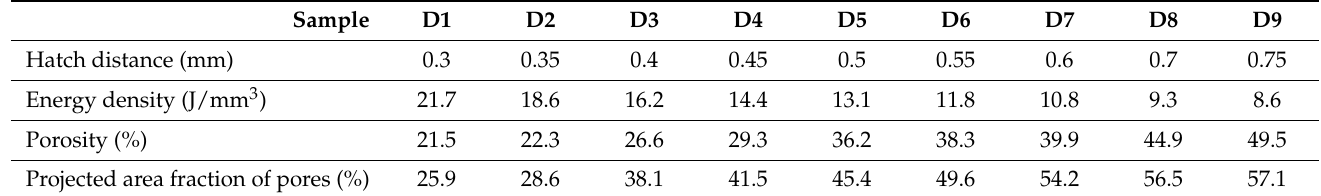
Figure 1. SEM image of printed structures showing average 0.13 mm scan line width and 0.3 mm hatch distance (or D1 specimen in Table 2). Table 2. SLM process parameters and porosity as obtained with fixed 285 W laser power, 960 mm/s scanning speed, and 40 μ m layer thickness. D1~D9 identify the samples made by changing hatching distances.